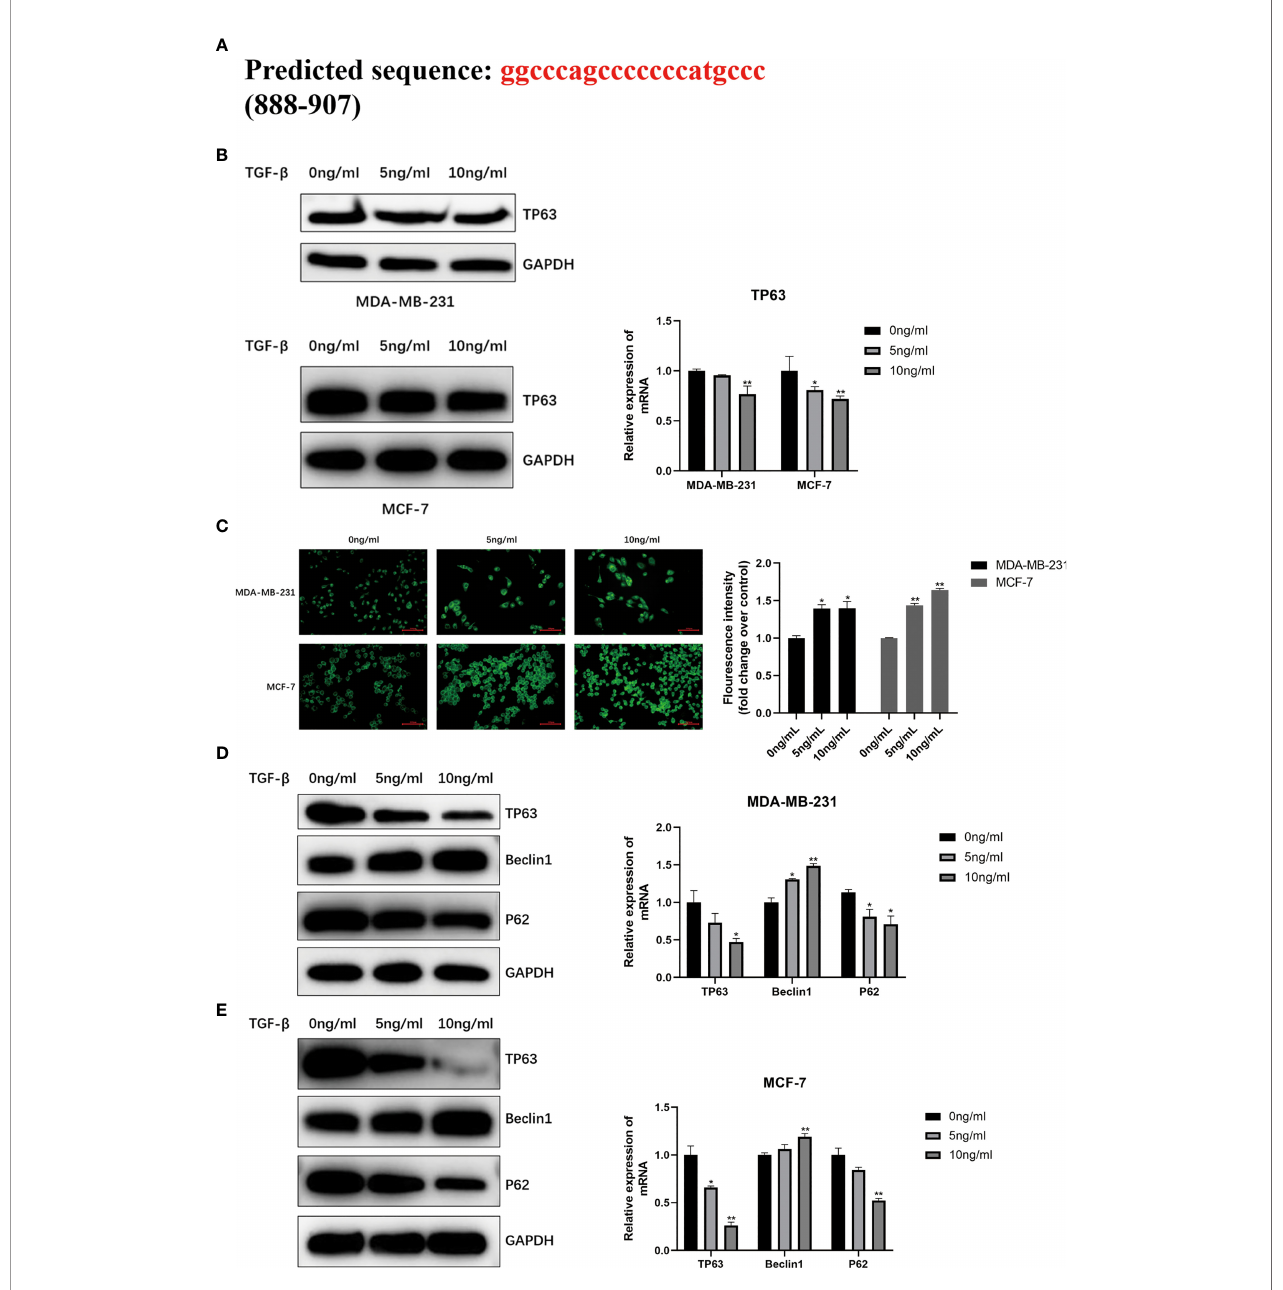
FIGURE 4 | (A) Predicted the TGF- b 1 target TP63 potentially by using JASPAR database (http://jaspar.genereg.net/) and veri fi ed the TGF- b 1 is negatively correlated with TP63 (B) . MDC staining was used to analyze autophagy (C) . When MDA-MB-231 cells and MCF-7 cells were induced by TGF- b 1 for 24 hours, MDC staining was performed in the dark and observed under a fl uorescence microscope immediately. Fluorescence intensity was quanti fi ed by ImageJ and shown as mean ± SD. The expression level of the autophagy-related proteins and TP63 in MDA-MB-231 cells (D) and MCF-7 cells (E) with TGF- b 1 induced. GAPDH was used as an internal control. Quantitative analysis of TP63, Beclin1, and P62 are expressed as the mean ± SD (*p < 0.05, **p <